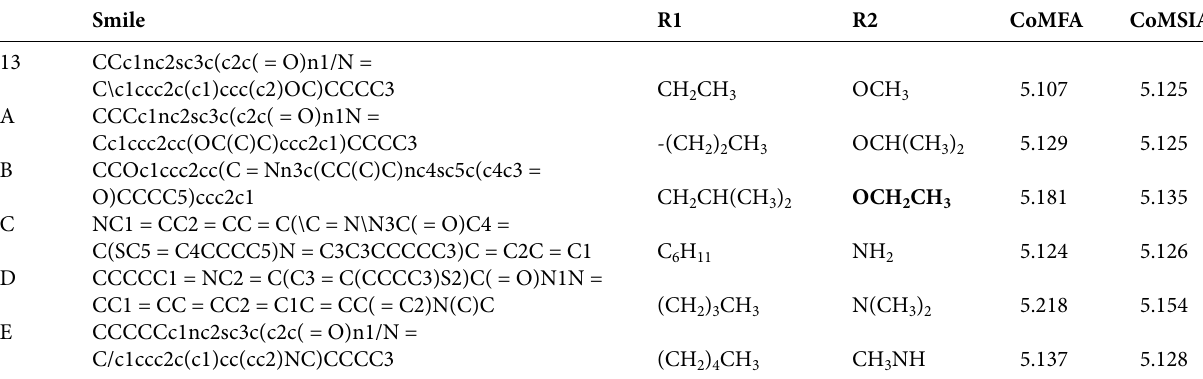
Table 4. Structures of newly designed molecules and their predicted pIC50 based on CoMFA and CoMSIA 3D-QSARmodels.